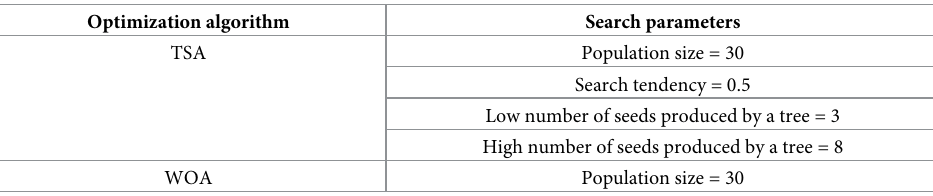
Table 3. Parameters involved in the results.